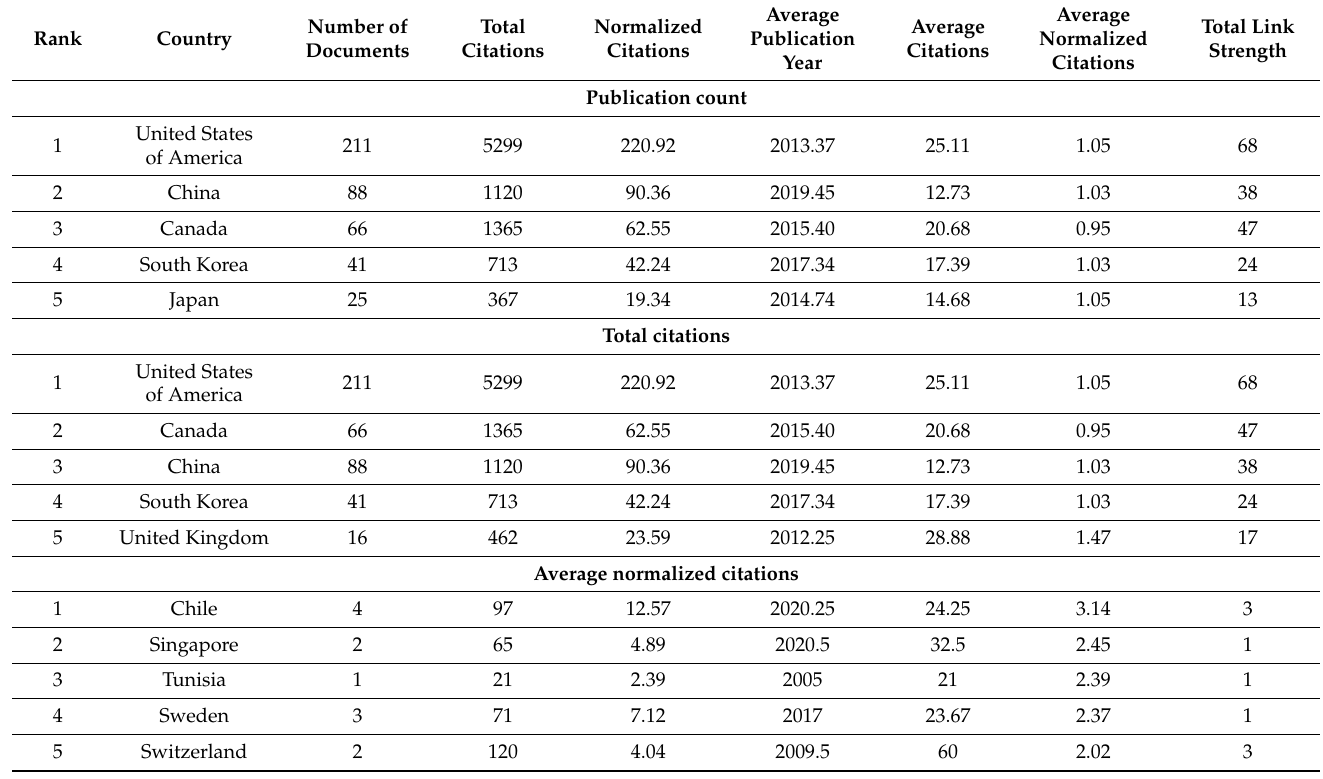
Table 1. Quantitative summary of active countries in the field of CBD_NDT with regards to publica- tion count, total citations and average normalized